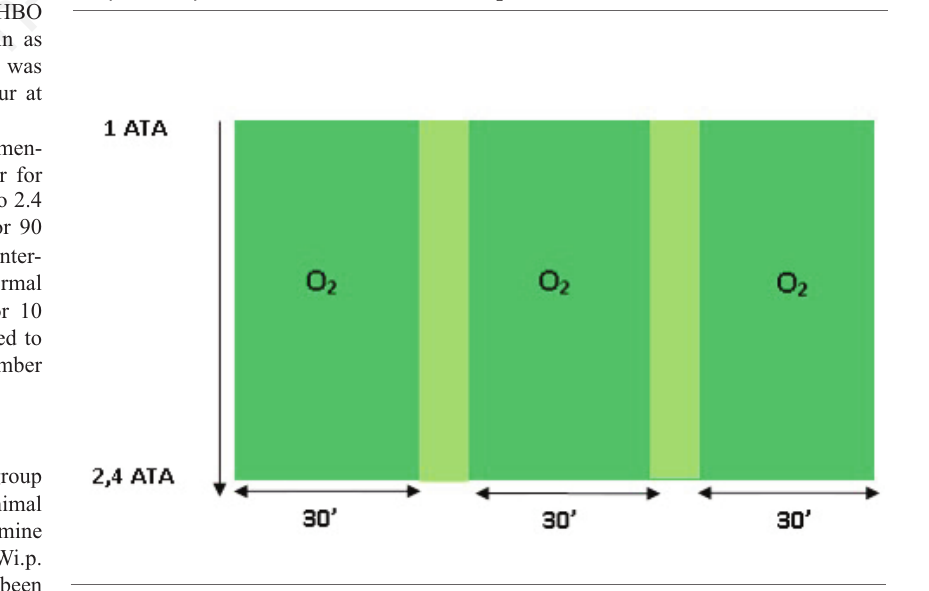
Figure 1. (a) Animal chamber was made of steel in the Naval Health Institute, Indonesian Navy, Surabaya, Indonesia; (b) ACIA when exposed to HBO in the animal chamber.